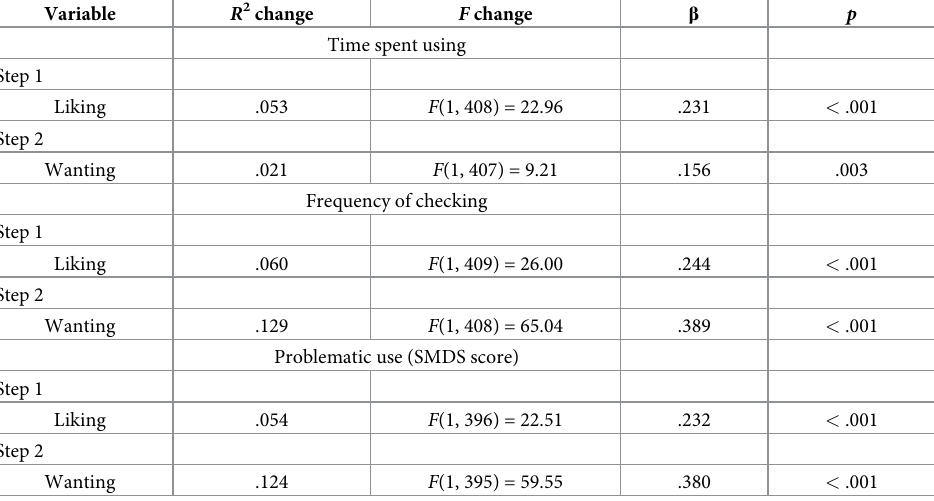
Table 2. Summary of regression analyses for the prediction of problematic use, frequency of checking and time spent on SNSs from wanting when controlling for